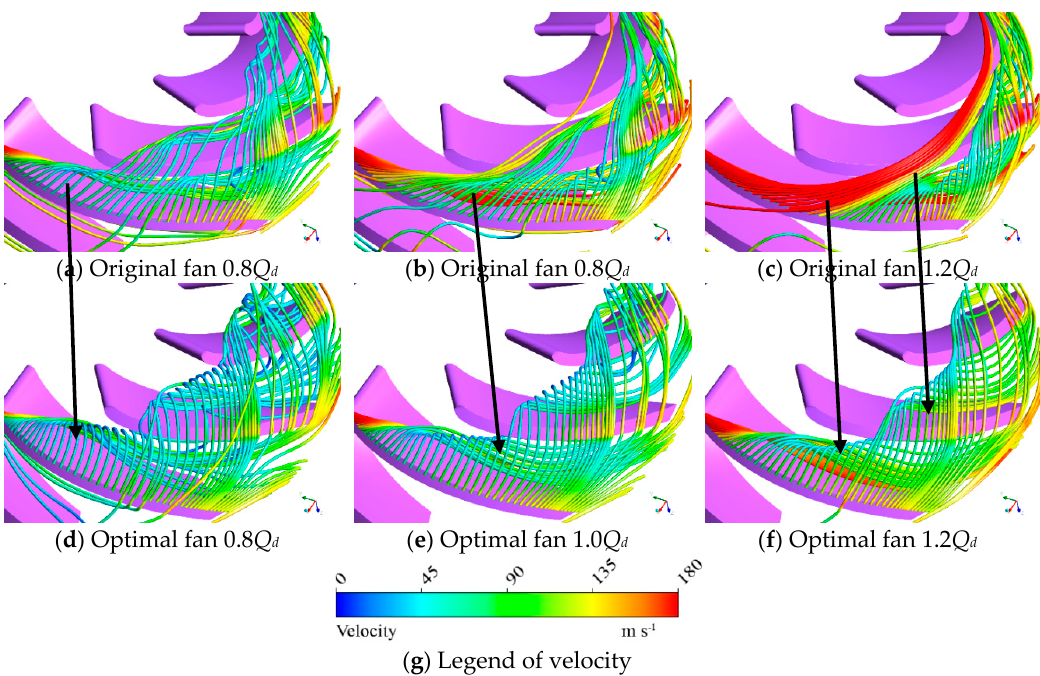
Figure 9. Streamline distribution in tip clearance. ( a ) Original fan 0.8 Q d ; ( b ) Original fan 0.8 Q d ; ( c ) Original fan 1.2 Q d ; ( d ) Optimal fan 0.8 Q d ; ( e ) Optimal fan 1.0 Q d ; ( f ) Optimal fan 1.2 Q d ; ( g ) Legend of velocity.